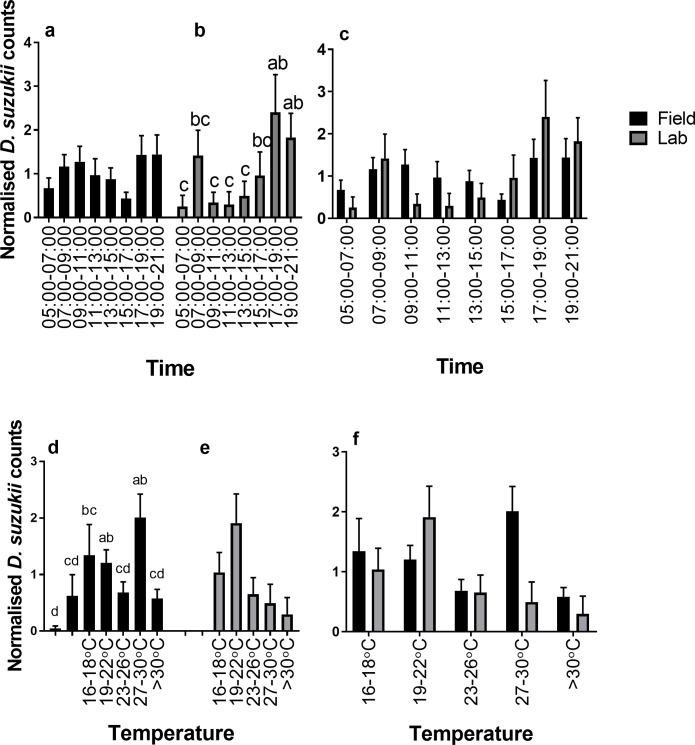
Normalised D. suzukii oviposition under August conditions in relation to time and temperature.Normalised counts of D. suzukii reproductive oviposition from (a) field assay (+SE) (black bars) and (b) laboratory oviposition (+SE) (grey bars) in August conditions and (c) field vs. laboratory (+SE) in relation to time. Normalised counts of D. suzukii reproductive oviposition from (d) field assay (+SE) and (e) laboratory oviposition (+SE) in August conditions and (f) field vs. laboratory (+SE) in relation to temperature. Different letters identify significant differences between time points within each setting.